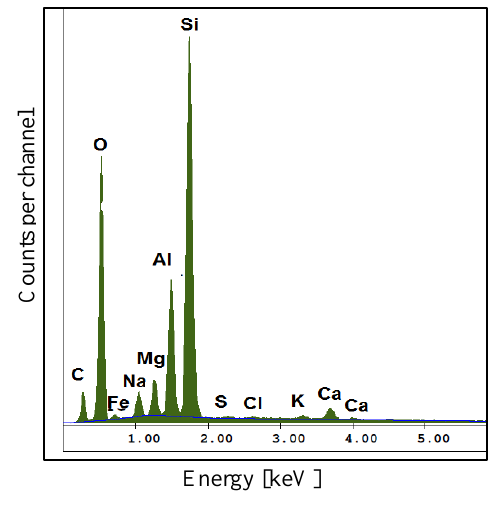
Figure 3: EDS analysis.